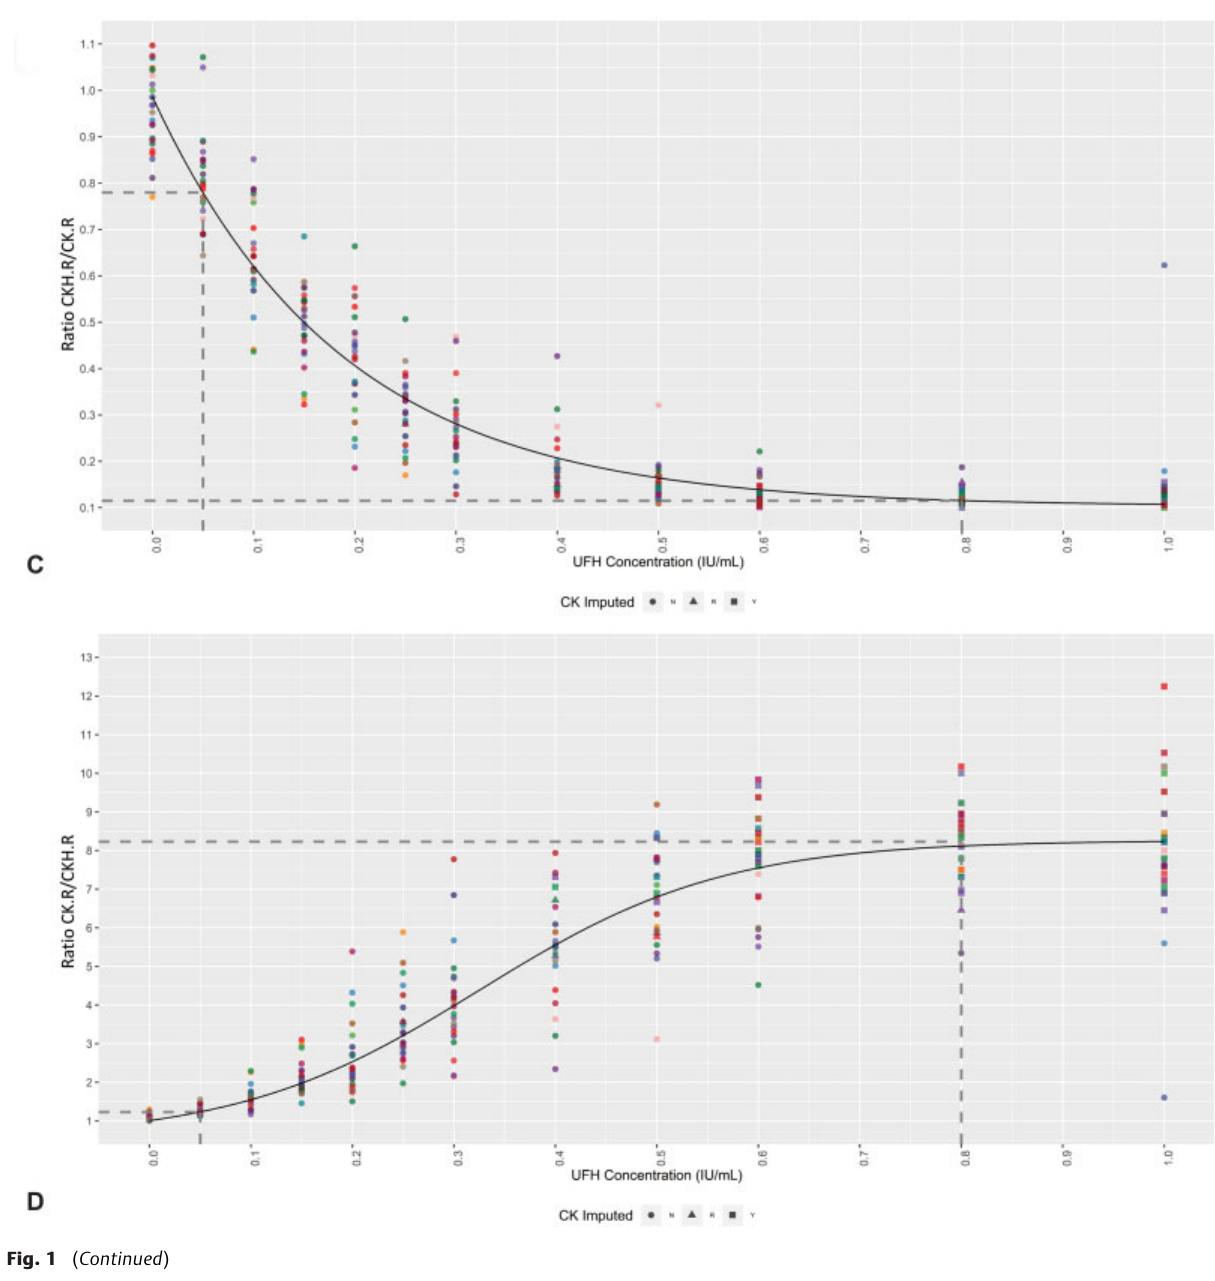
Table 2 Minimum and maximum quanti fi cation window for UFH and LMWH for the combination parameters and CRT.ACT UFH LMWH Minimum Reference Maximum Minimum Reference Maximum (IU/mL) range cutoff (IU/mL) (IU/mL) range cutoff (IU/mL) Ratio CKH.R/CK.R 0.05 No range 0.8 0.1 No range 1.5 Ratio CK.R/CKH.R 0.05 No range 0.8 Δ CK.R (cid:3) CKH.R